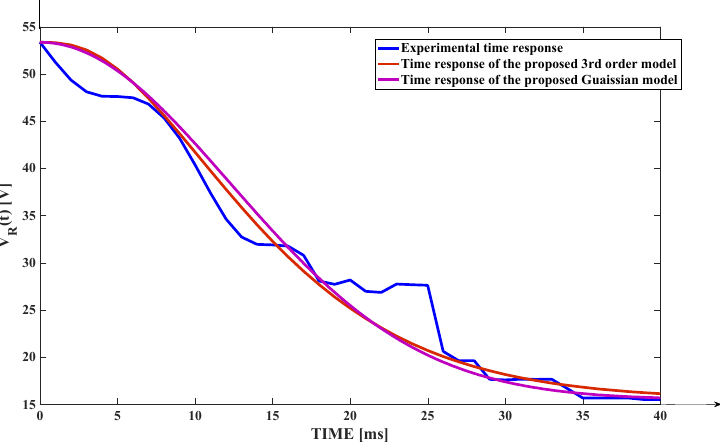
Figure 15. Comparative graph between the experimental response and the responses of the two identified mathematical